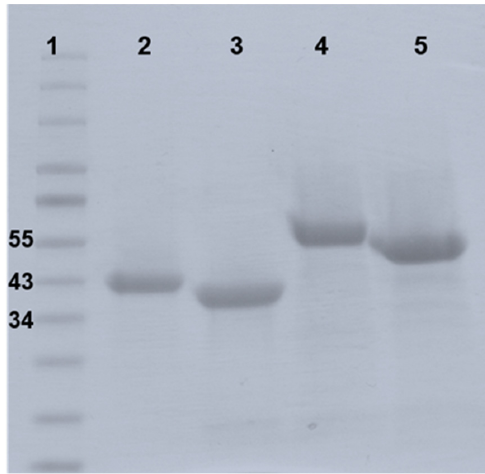
Figure 4. SDS-page gel of purified endolysins PlyB221 and PlyP32. The recombinant proteins were expressed in E. coli BL21(DE3) and purified thanks to a six-histidine tag on a Ni-NTA column. Lane